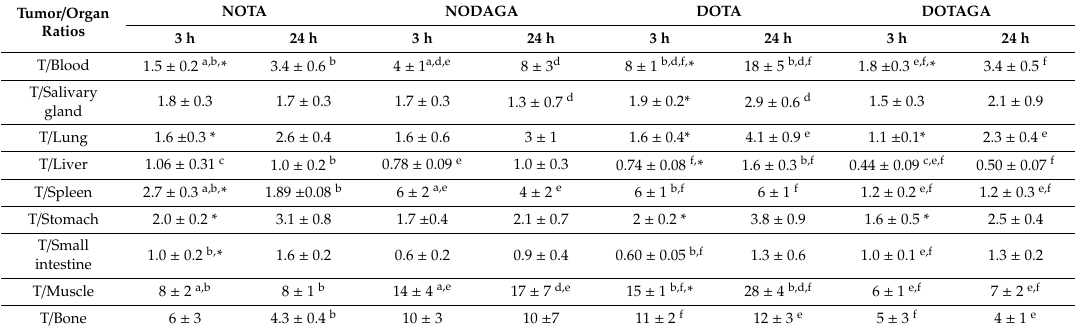
Data presented as the average ± SD of n = 4 animals per group. Significant di ff erence ( p < 0.05) between a : NOTA vs. NODAGA, b : NOTA vs. DOTA, c : NOTA vs. DOTAGA, d : NODAGA vs. DOTA, e : NODAGA vs. DOTAGA, f : DOTA vs. DOTAGA; * significant di ff erence to 24 h.